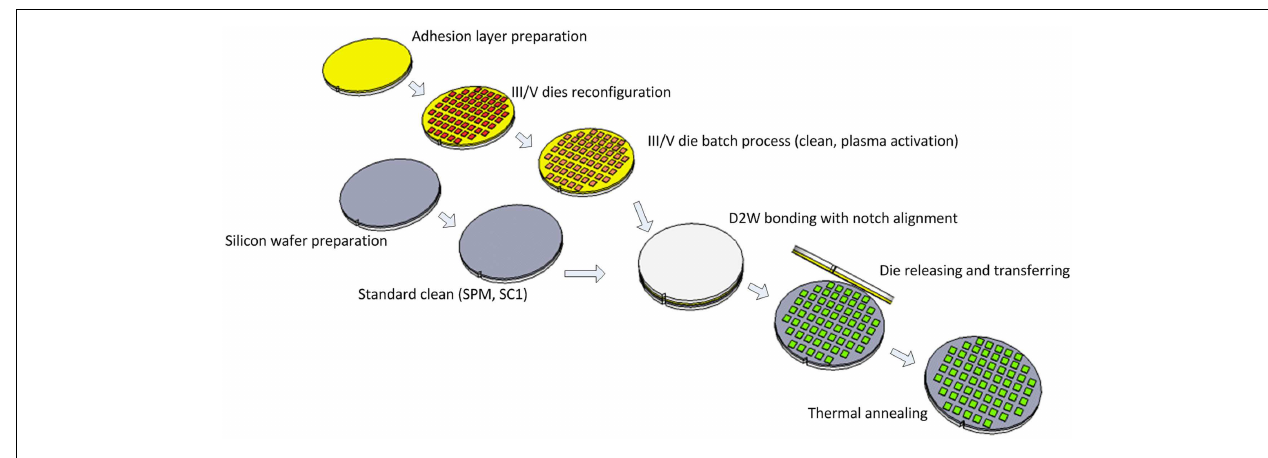
batch process and the silicon device wafer fabrication, and D2W bonding through dies releasing from handle wafer and transferring to silicon device wafer.